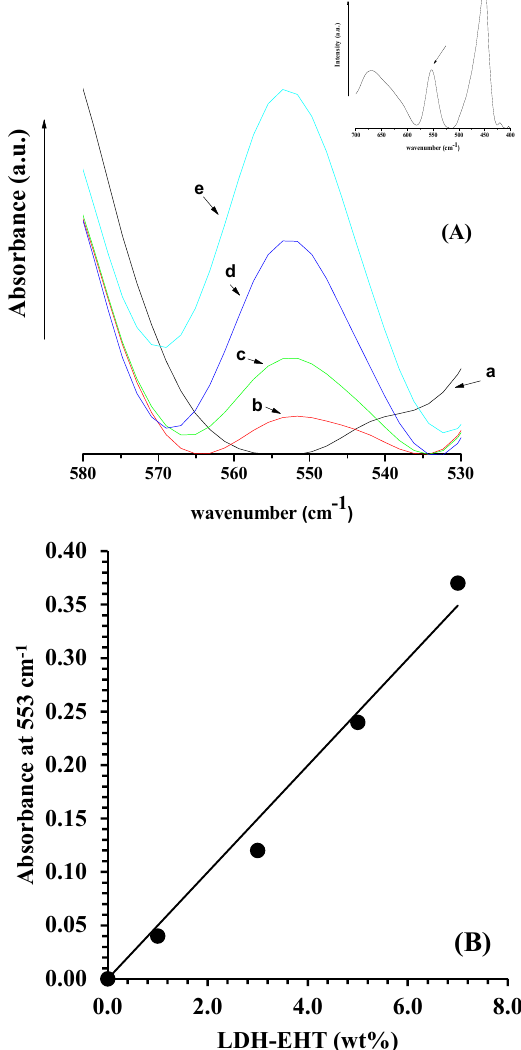
Figure 3. ( A ) FTIR spectra, in the range 530–580 cm − 1 , of: PCL ( a ); PCL/1% LDH-EHT ( b ); PCL/3% LDH-EHT ( c ); PCL/5% LDH-EHT ( d ); and PCL/7% LDH-EHT ( e ). The inset reports the spectrum of pure LDH-EHT. ( B ) Absorbance at 553 cm − 1 as a function of LDH-EHT (wt %).